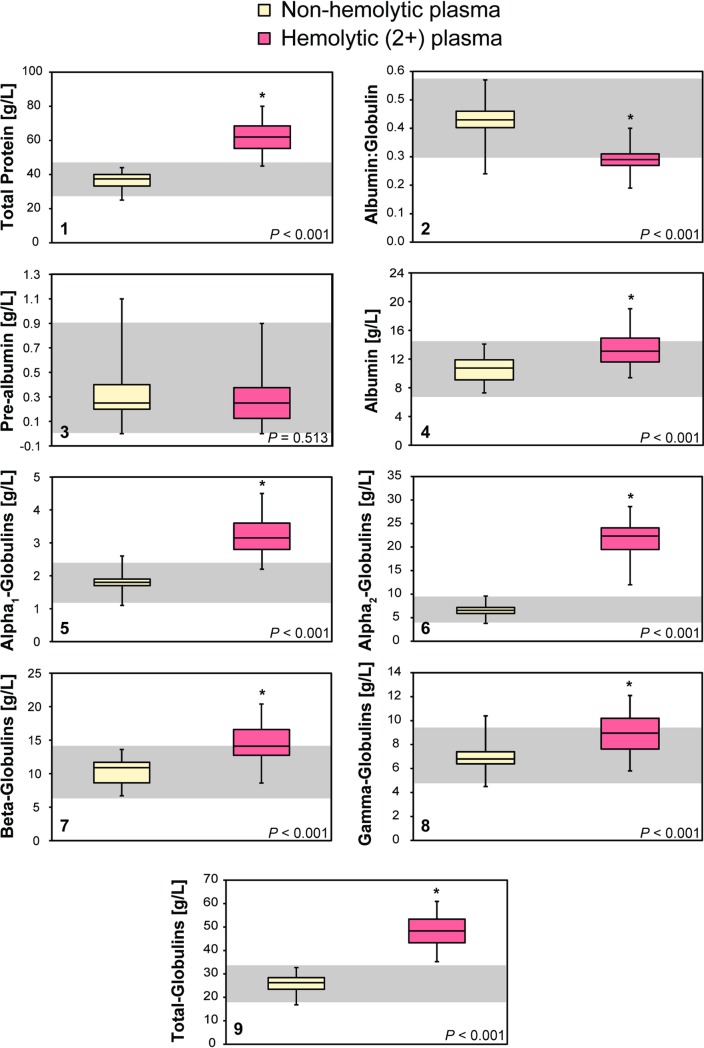
Comparison of proteins (1: total protein; 2: albumin:globulin ratio; 3: pre-albumin; 4: albumin; 5: alpha1-globulins; 6: alpha2-globulins; 7: beta-globulins; 8: gamma-globulins) in non-hemolytic and hemolytic plasma from leatherback sea turtles (Dermochelys coriacea).The line represents the median, the boxes represent the first and third quartiles, while the whiskers represent the range. * indicates a significant difference between the two samples as determined by a paired-samples t-test (P < 0.0033). Data is presented in SI units.